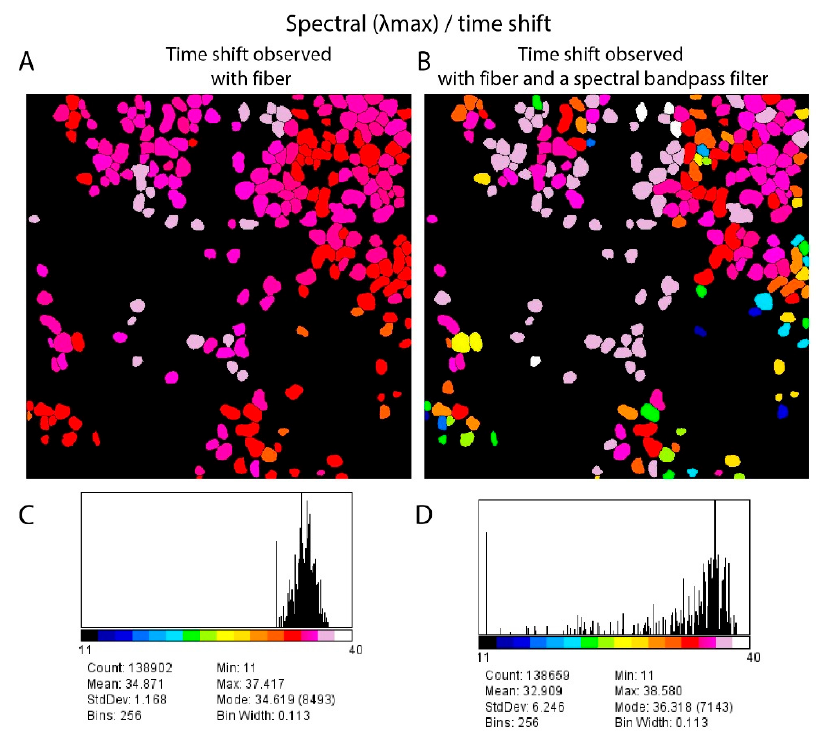
Figure 6. Spectral Contrast using a filter. The spectral peak mapping using fiber dispersion and timing electronics is shown in panel ( A ). The same area gets a larger contrast when a 630/69 nm filter is added before the fiber (panel B ). Comparing both image histograms is shown in panels ( C ) and ( D ) for panels ( A ) and ( B ), respectively. The images are 1.14 mm in size and use the same segmentation scheme shown before. The color scales of panels ( A ) and ( B ) are shown along the histograms presented in panels ( C ) and ( D ).